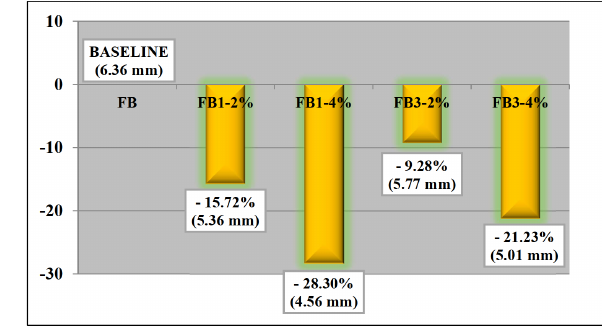
Figure 5: Vertical deformation of fouled-ballast based specimen after the first loading strength tests twice. The decrease in vertical deformation in the second test in each specimen was due to higher den- sity level applied to the specimens. The first loading con- tributed to the increase in the sample’s stiffness. For clean- ballast based structure, CB1-4% specimen produced the lowest total vertical deformation (5.58 mm), followed by CB3-4% (5.96 mm), CB1-2% (6.48 mm), and CB3-2% (6.71 mm), as compared to CB specimen at 7.30 mm. For fouled- ballast based structure, FB1-4% specimen produced the lowest total vertical deformation (6.67 mm), followed by FB3-4% (7.45 mm), FB1-2% (7.86 mm), and FB3-2%